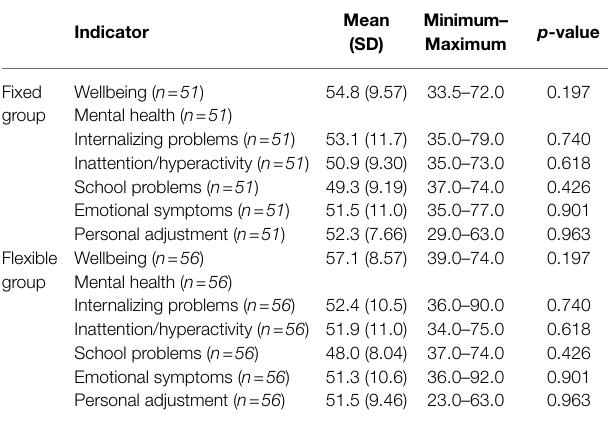
TABLE 5 | Mental health indicator results by group (fixed and flexible) for both genders.